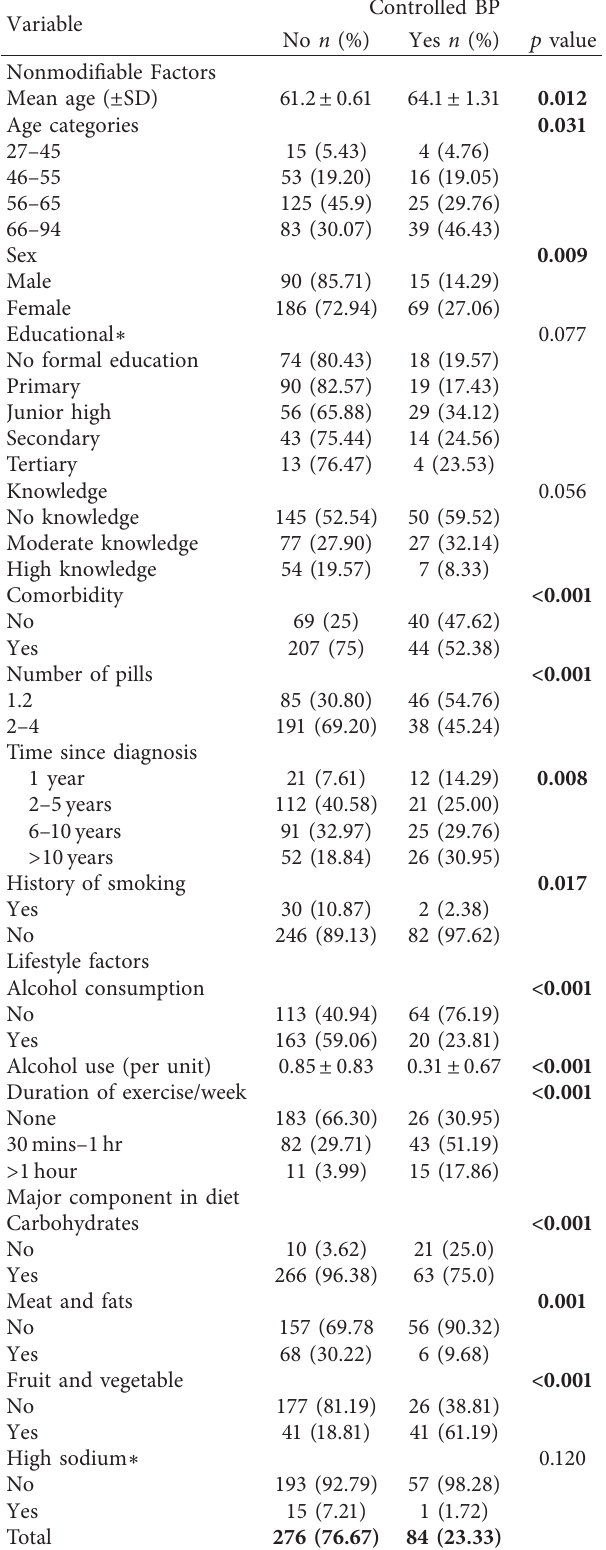
Table 2: Association between lifestyle characteristics and blood pressure